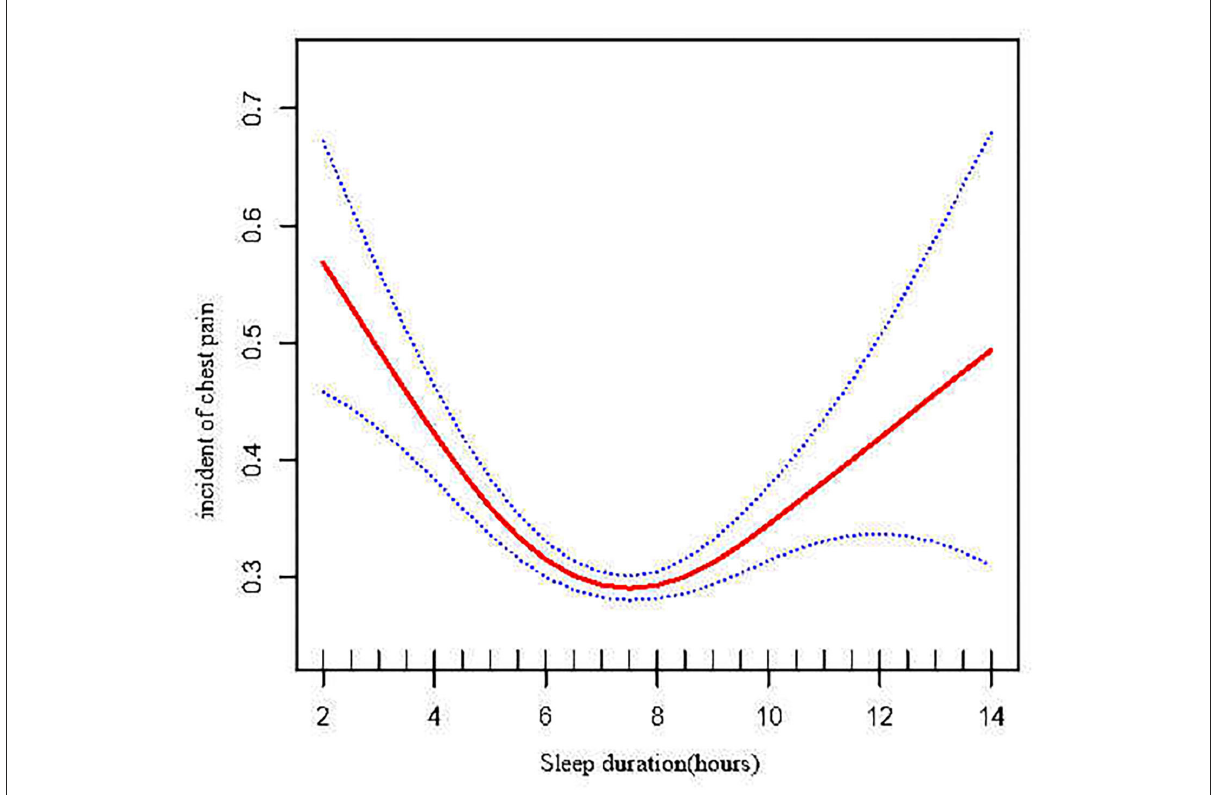
FIGURE2 Non-linear relationship of sleep duration and chest pain.